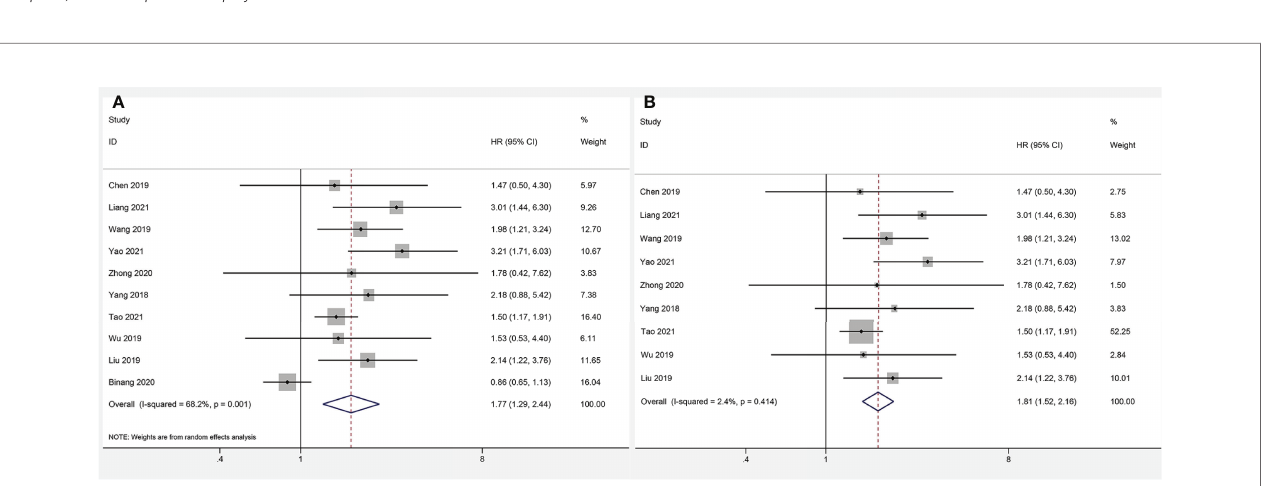
FIGURE 2 | ForestplotsforassociationofFOXP4-AS1expressionwithoverallsurvival. (A) Forestplotsoftheentireliterature. (B) ForestplotsafterexclusionofBinangetal,2020.